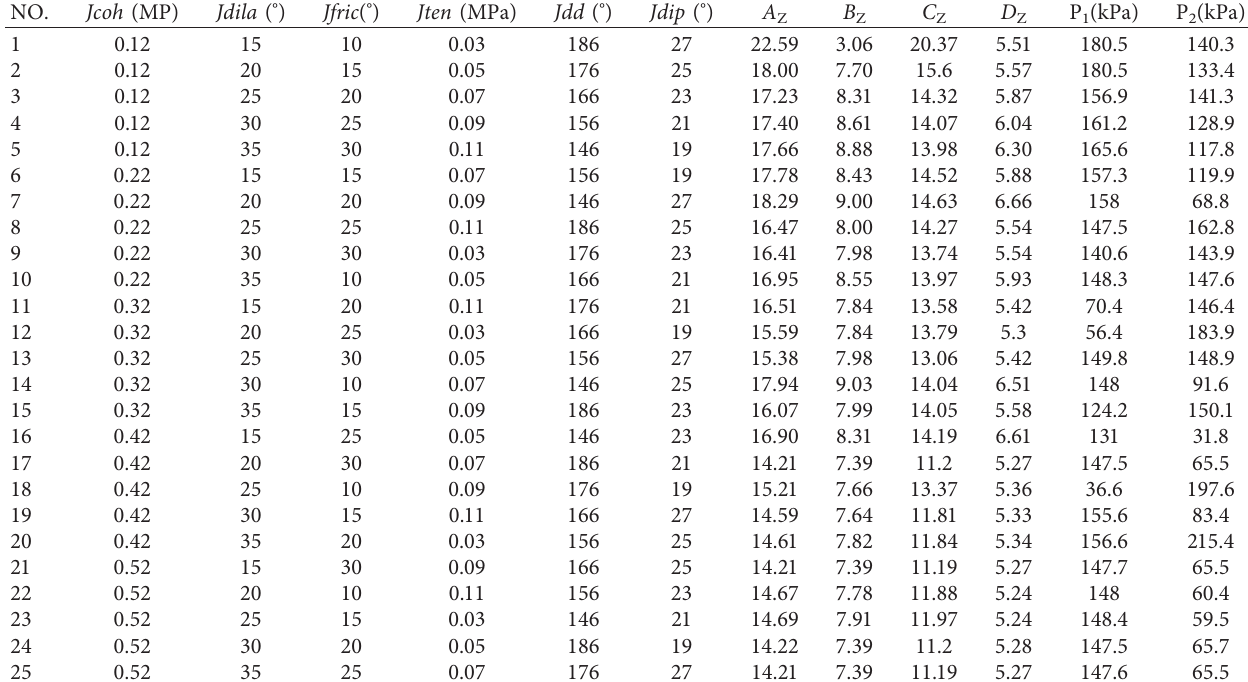
Table 2: Orthogonal design